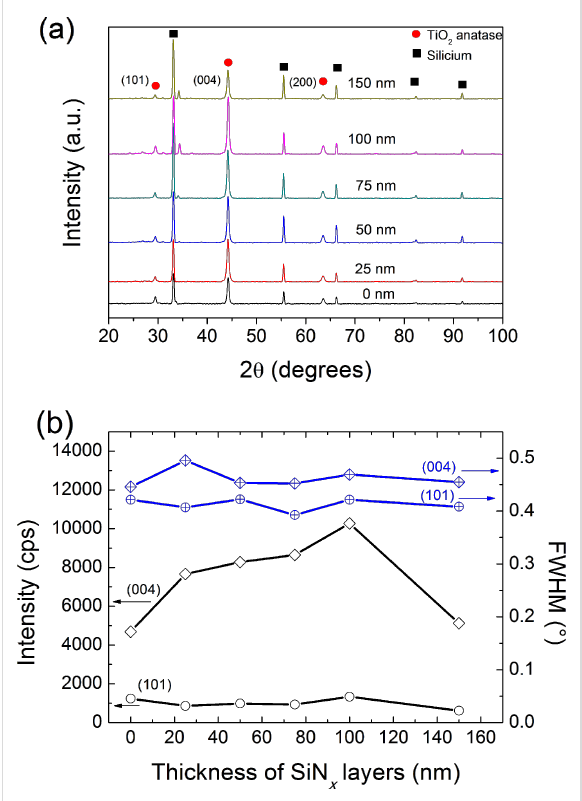
Figure 4: (a) XRD patterns and (b) FWHM of the (101) and (004) planes and their intensity of the TiO 2 coatings as a function of the thickness of the SiN x /SLG films.